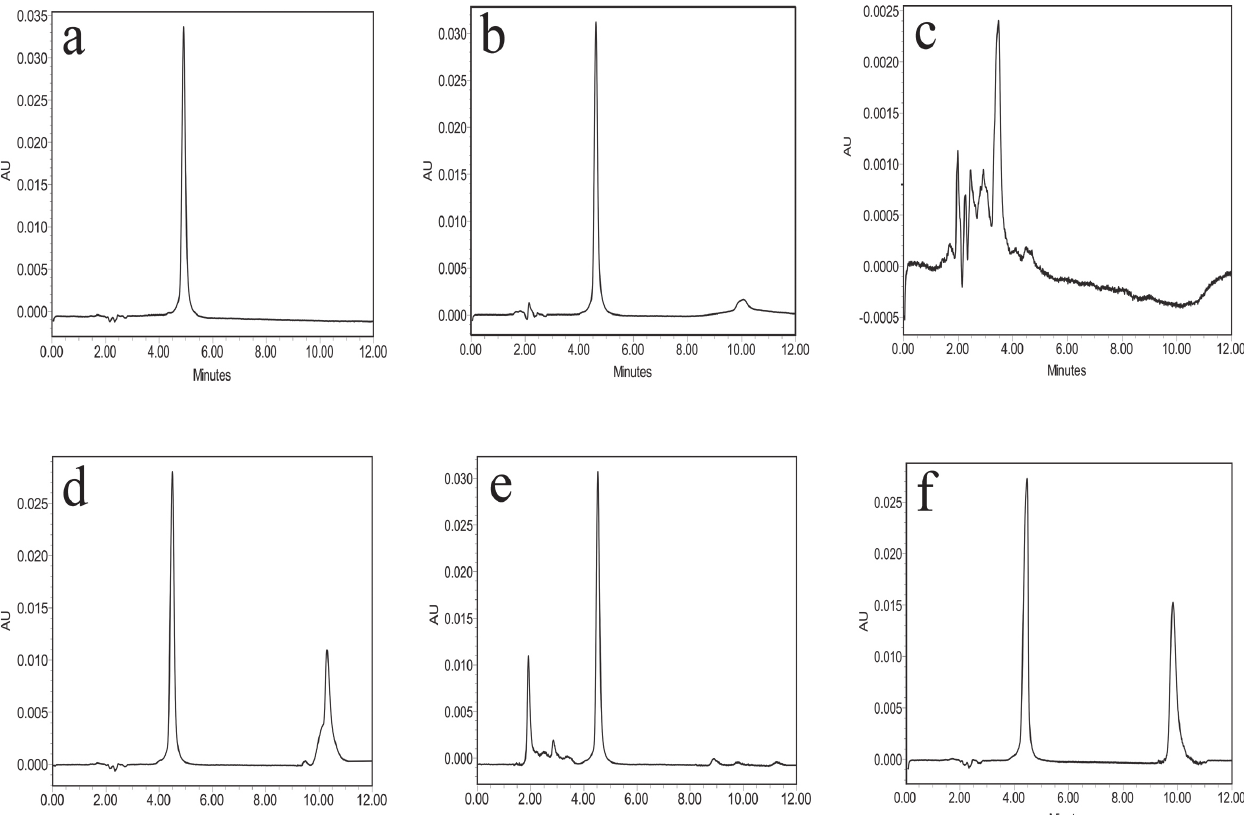
FIGURE 3 - Chromatograms obtained from forced degradation studies; a) Pure epirubicin hydrochloride; b) acid treatment; c) alkali treatment; d) Photo treatment; e) Oxidative treatment; f) Thermal